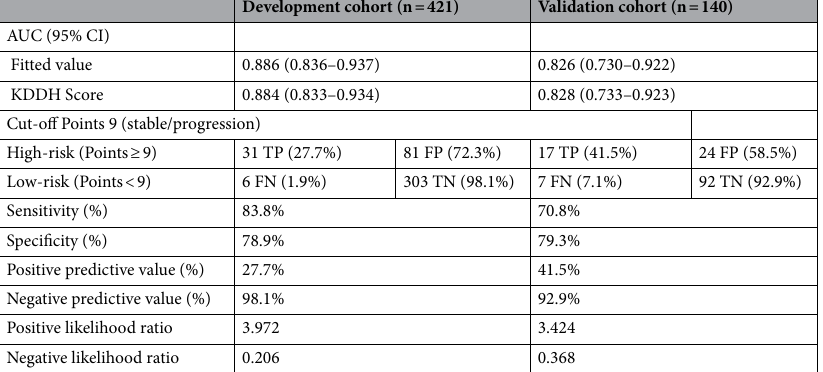
Development cohort (n = 421) Validation cohort (n =